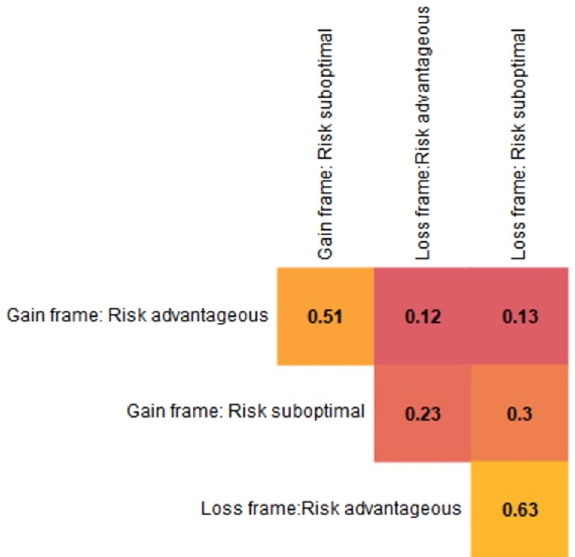
Fig. 2 Correlation between risky choices based on frame and risk advantage for the control group. Note. Items that share a frame but differ in risk advantage correlate more strongly than items that share the same advantageous option but differ on